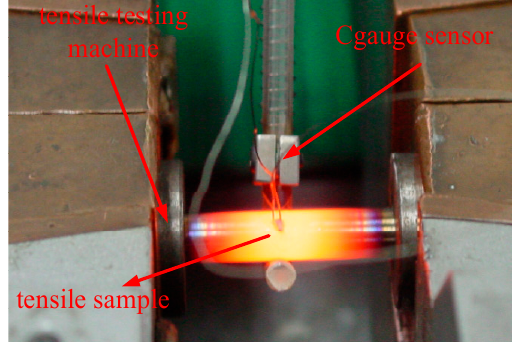
Table 3. Determination of elastic modulus E values of Cr5 steel at different temperatures.